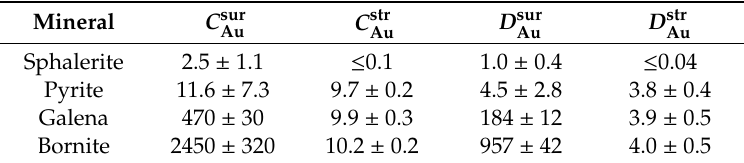
Table 5. Surficial and structural gold content ( C Au in µ g / g) in coexisting sulfides and corresponding mineral-fluid partition coe ffi cients (Experiment